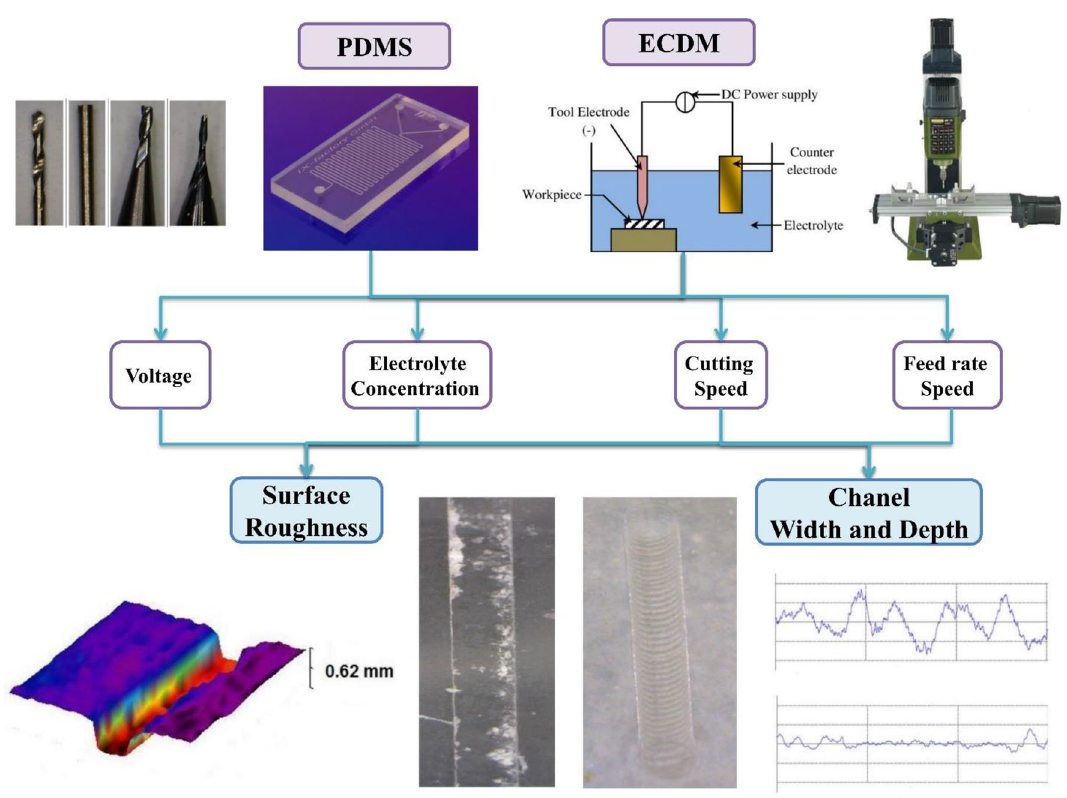
Fig. 2 Research block